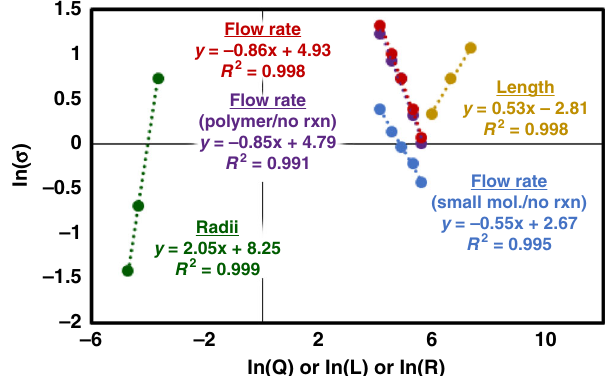
Fig. 4 Processed tracer experimental results. Green line is the best fi t for σ with different reactor radius ( R ). Tan line is the best fi t for σ with different reactor lengths ( L ). Red line is the best fi t for σ with different reactor fl ow rates ( Q ) while a polymerization is occuring. Purple line is the best fi t for σ with different reactor fl ow rates ( Q ) while no polymerization is occuring. Blue line is the best fi t for σ with different reactor fl ow rates ( Q ) using a small molecule tracer while no polymerization is occuring. ( σ : standard deviation of the normal distribution of tracer exiting the tubular